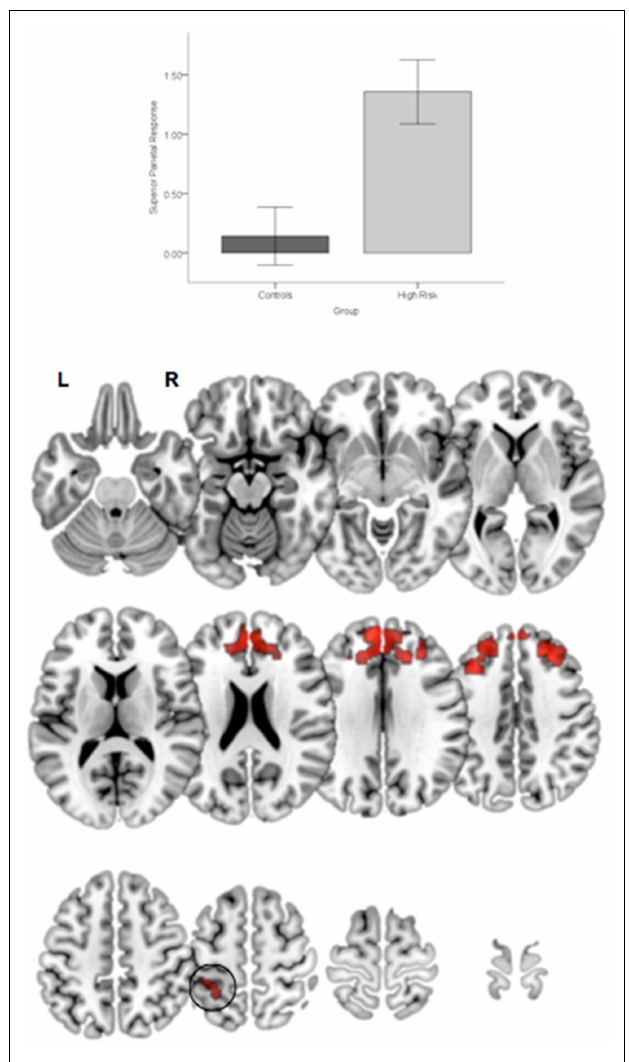
FIGURE 5 | Significant clusters ( p < 0.05, cluster level) under the overall main effect of group in the activation analyses represent significant hyper-engagement of the parietal cortex (inset) in HGR compared toTC (see graph of parameter estimates from the peak in parietal cortex) .The clusters are rendered on an ascending mosaic of axial surfaces.These results imply that HGR may inappropriately hyper-activate the parietal cortex during attention, suggesting an imbalance in the relative specialization of function underlying sustained attention.